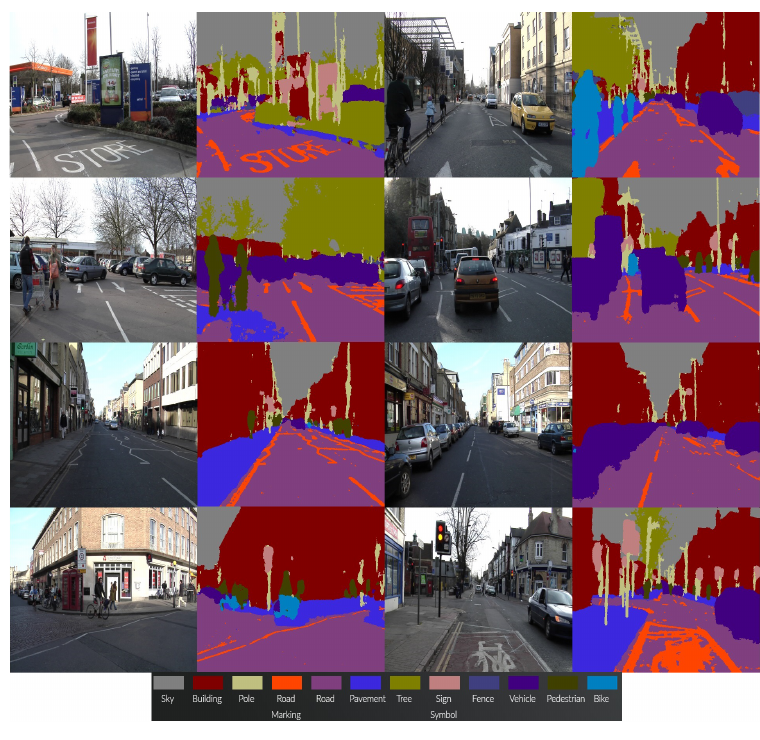
Figure 5. ECRU final